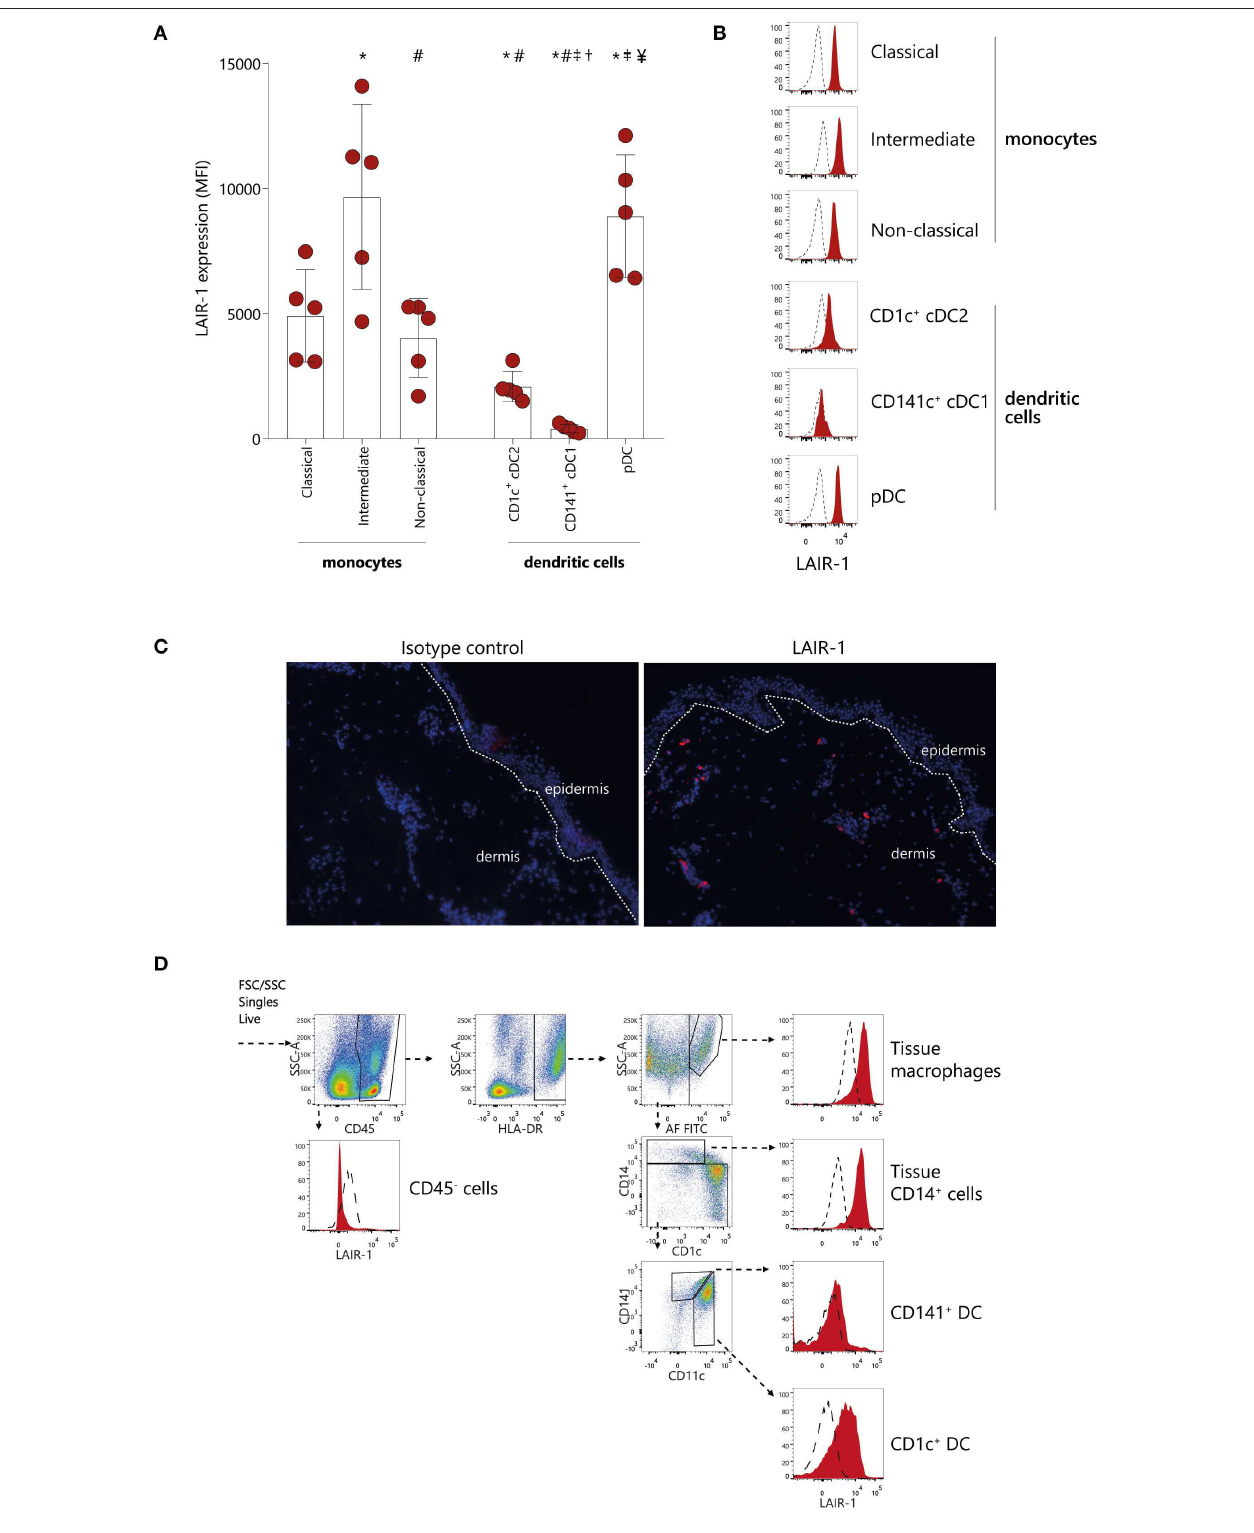
FIGURE 1 | LAIR-1 is differentially expressed on circulating monocytes subsets and dendritic cells subpopulations and on skin immune cells. (A) Quantification and (B) representative histograms of LAIR-1 expression, represented as median fluorescence intensity (MFI), on classical, intermediate and non-classical monocytes as